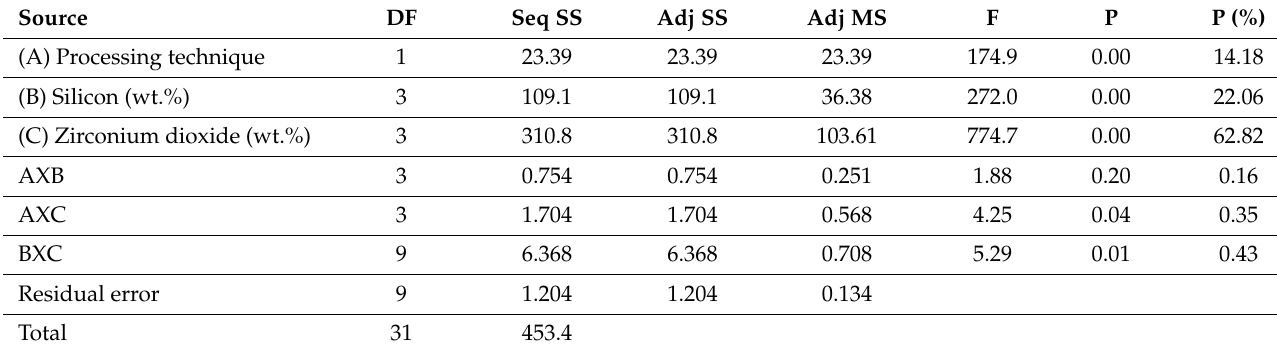
Table 6. ANOVA for SN ratios.